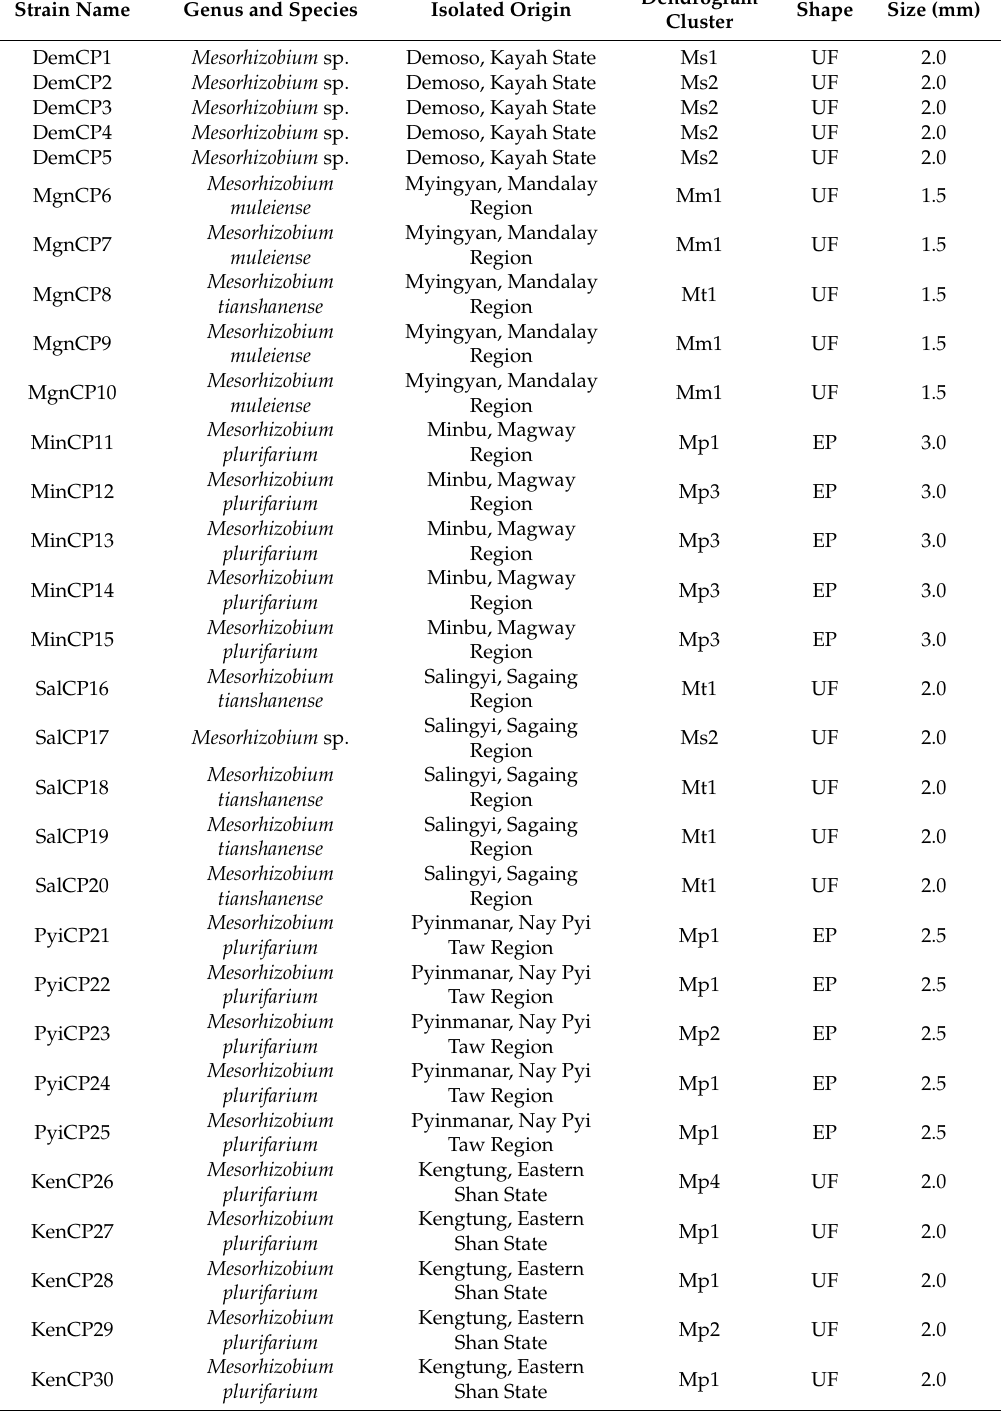
Table 3. The origin and morphological characteristics of Chickpea mesorhizobial isolates from Myanmar on yeast mannitol agar (YMA) with congo red plates after 3-5 days incubation at 30 ◦